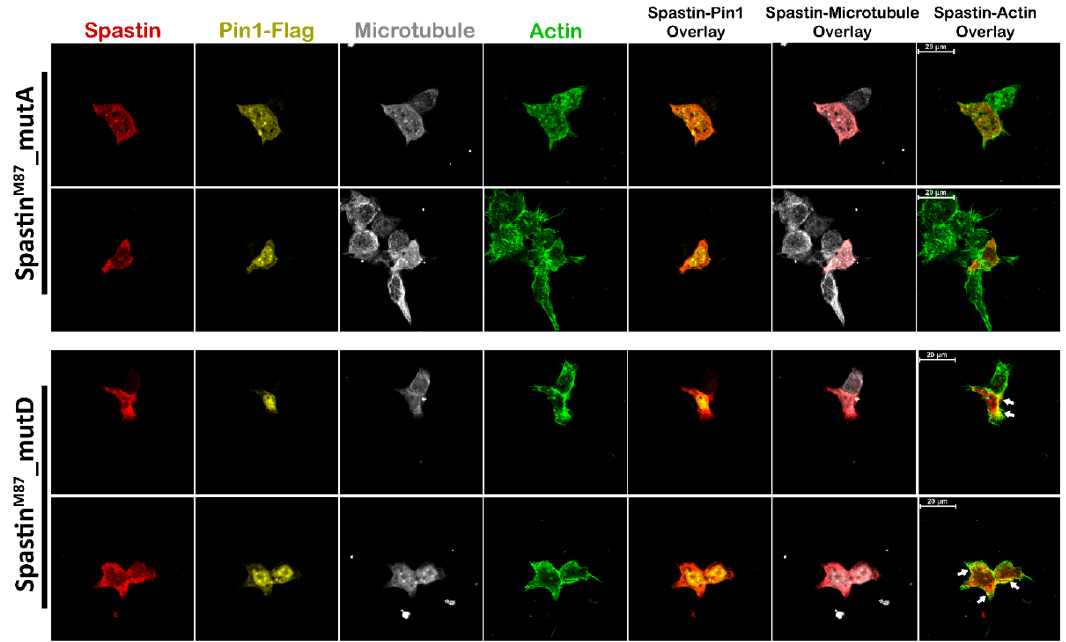
Figure 7. M87-Spastin is directed to actin filaments due to its interaction with Pin1. T98G cells were dually transfected with each mutant M87 vector (Spastin M87 _mutA or Spastin M87 _mutD) and Pin1-Flag vector. After 24 h of transfection, cells were fixed with PFA and stained with Myc-tag antibody for Spastin (red), Flag-tag antibody for Pin1 (yellow), phallacidin for actin filaments (green), and tubulin antibody for microtubule (gray). Arrows indicate color transformation caused by the co-localization of Spastin with actin